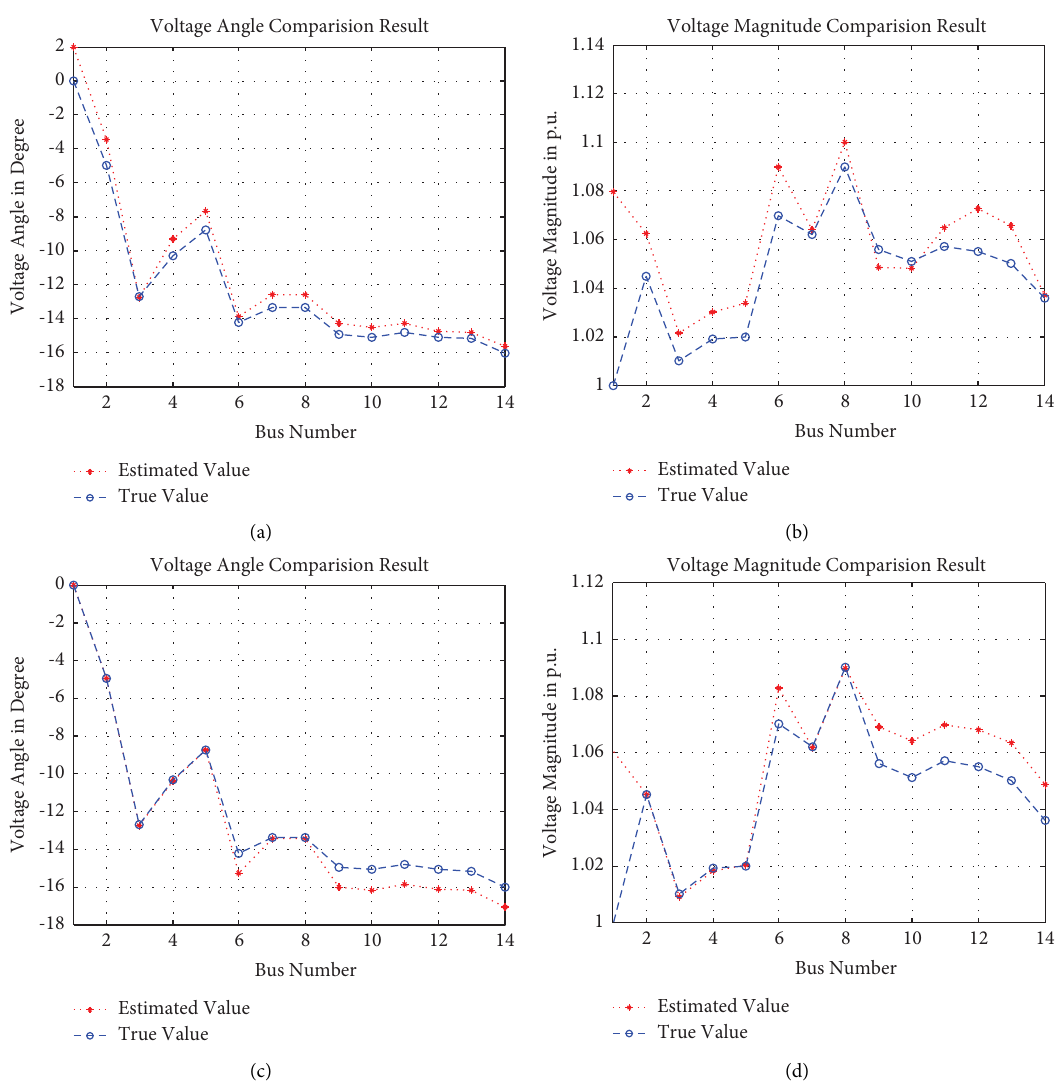
Figure 2: Comparison of true and estimated values for the magnitude and phase of the voltage of busbars in the 14-bus network by performing scenarios 5 and 6 by applying an outlier of the type of active power change fow between busbars 2 and 3. (a) Phase of busbars voltage—scenario 5. (b) Magnitude of busbars voltage—scenario 5. (c) Phase of busbars voltage—scenario 6. (d) Magnitude of busbars voltage—scenario